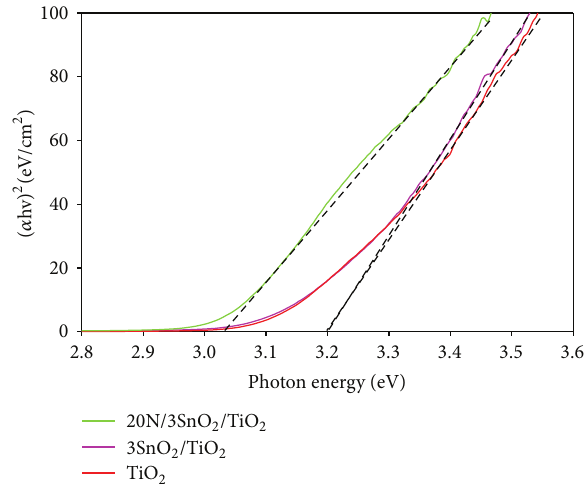
Figure 5: The photon energy versus ( 𝛼 hv) 2 curve of representative pure TiO 2 , 3SnO 2 /TiO 2 , and 20N/3SnO 2 /TiO 2 samples calcined at 600 ∘ C.